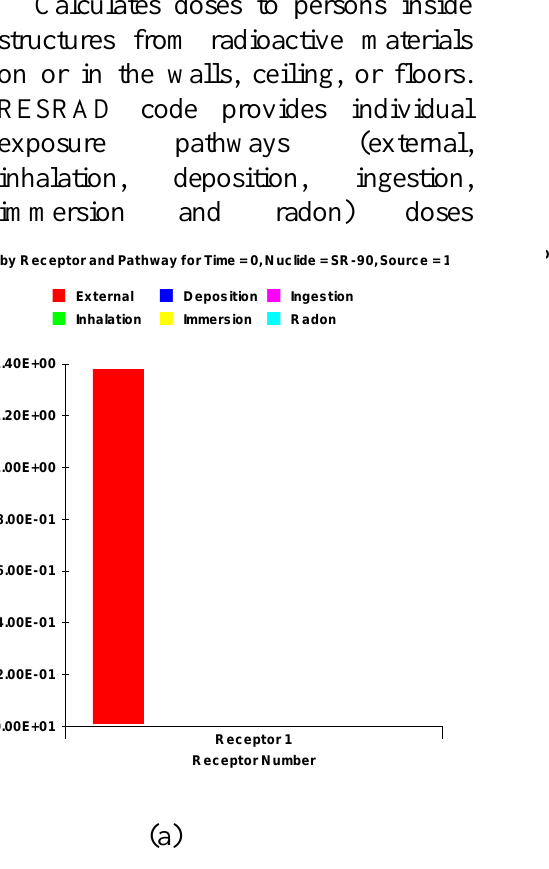
Fig.3: a- Dose without shielding, b- Dose with